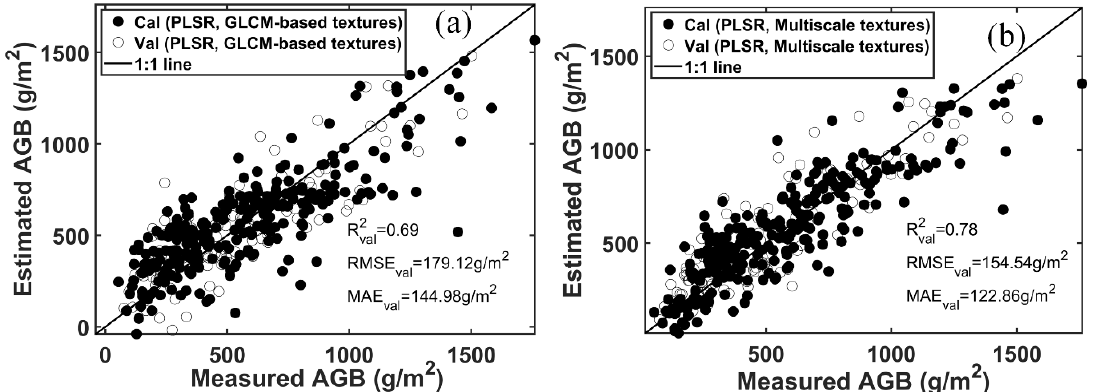
Figure 6. Predictive performance of the PLSR models using ( a ) the single-scale GLCM-based textures and ( b ) multiscale textures for winter wheat AGB estimation.